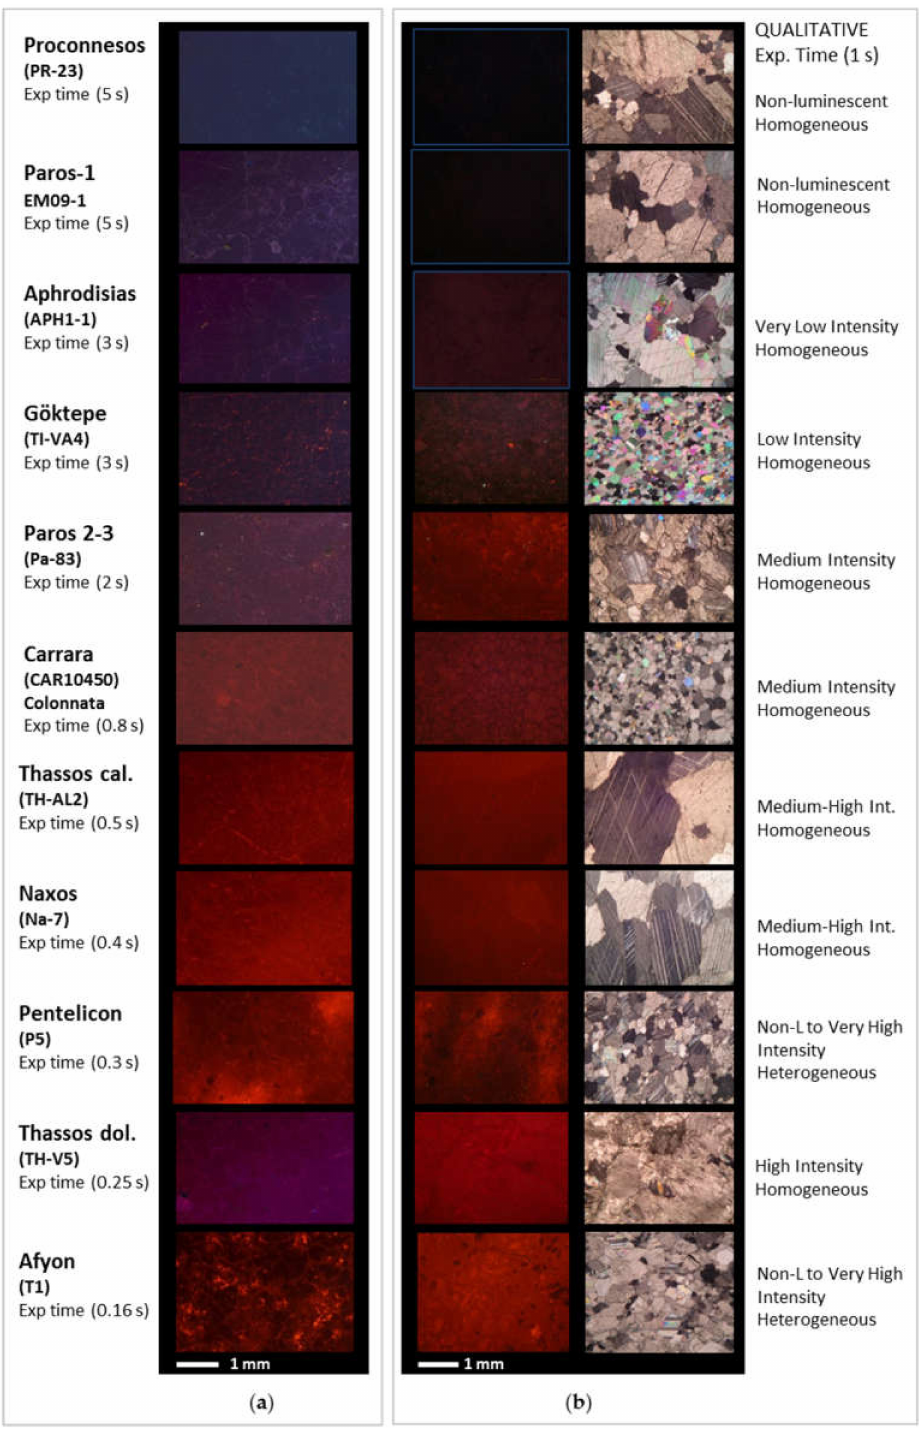
Figure 11. Inter-laboratory comparison of CL-images from the main white marbles used in ancient times. ( a ) CL-microphotographs taken at the Parisian laboratory of Pierre et Marie Curie, Sorbonne-University (vacuum 0.08 mbar, beam current 250–300 µ A, electron energy 12–15 kV, 1 / 6 s to 5 s of exposure time, ISO 500). They are organized sequentially in decreasing order of the exposure time; ( b ) CL-images and the respective microphotograph in crossed polars of the same thin-sections taken at the laboratory of ICAC in Tarragona (vacuum 0.17 mbar, beam current 250–300 µ A, electron energy 15–20 kV, automatically recorded at 1 s exposure time, 29 mm focal length, f / 4.6 aperture,